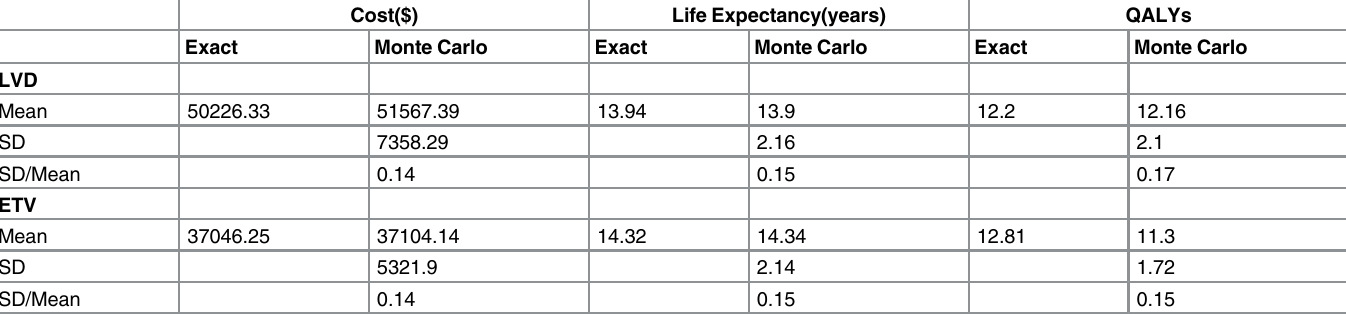
Table 6. Comparison of variation of cost, life expectancy and quality-adjusted